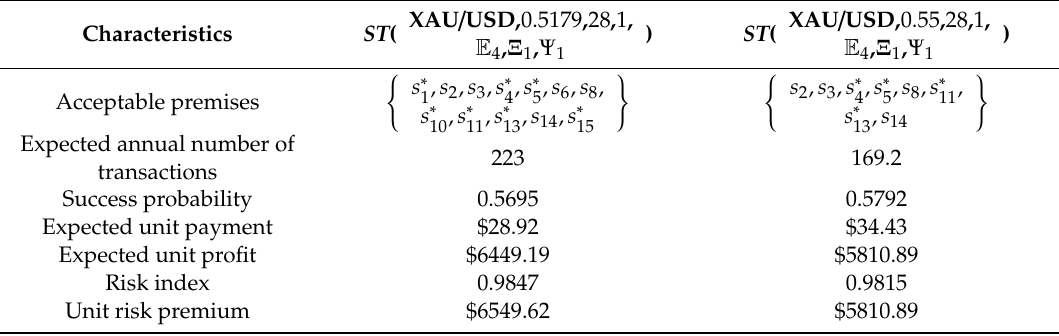
Table 6. Juxtaposition of local characteristics of ST systems applied for XAG/USD market. Characteristics